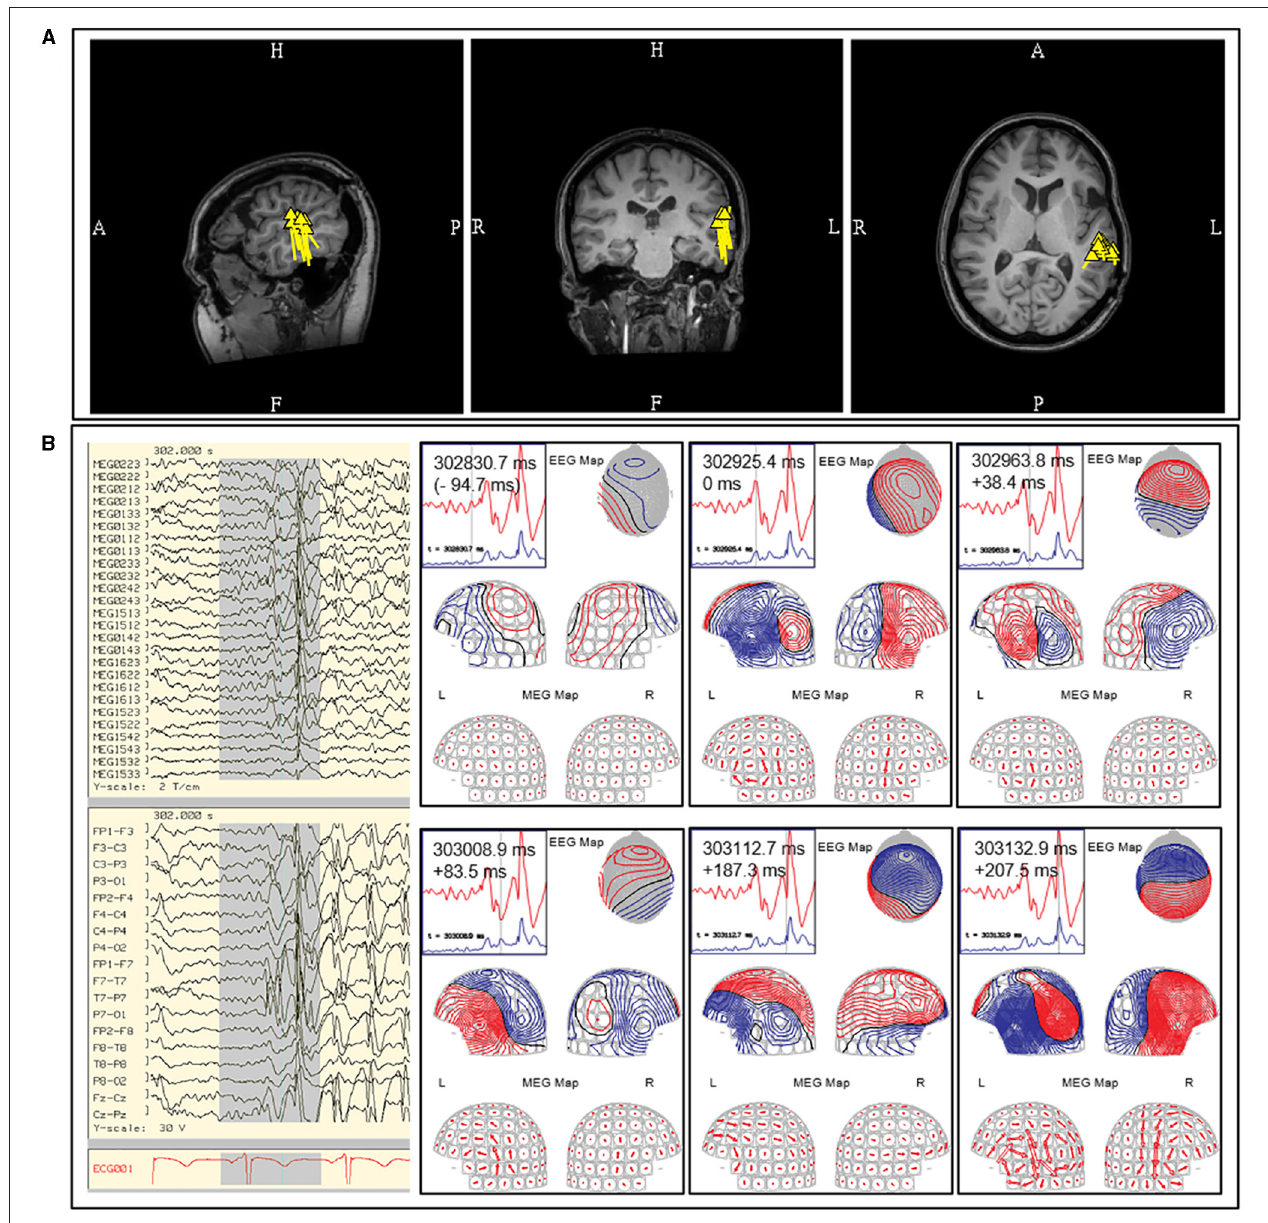
FIGURE 9 | Example of posterior temporal vertical dipoles that represent propagated activity. This MEG was performed in a patient with prior subdural recording which indicated a left frontal onset, but continued to have seizure after resection. The MEG study contained both (A) independent focal left posterior temporal discharges that formed a tight and uniform cluster and (B) bilateral posterior temporal discharges that were rapidly synchronous (upper middle diagram at 302925.4ms; initial peak defined as 0ms; left-right peak difference < 10ms). Data from prior subdural recording and the presence of bilateral synchronous discharges suggest alternate source of origin for this MEG cluster. The MEG current (arrow plot) suggested an underlying left frontotemporal current that cannot be modeled. These findings were described to the referring epileptologist.